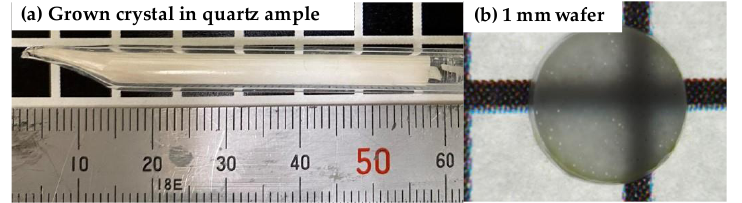
Figure 2. Images of the ( a ) as-grown crystal and ( b ) 1-mm polished wafer of the grown eutectic. (hexagonal, P63/m, 176), LiCl (cubic, Fm-3m, 225) and CaCl 2 (bipyramidal, Pnnm, 58)